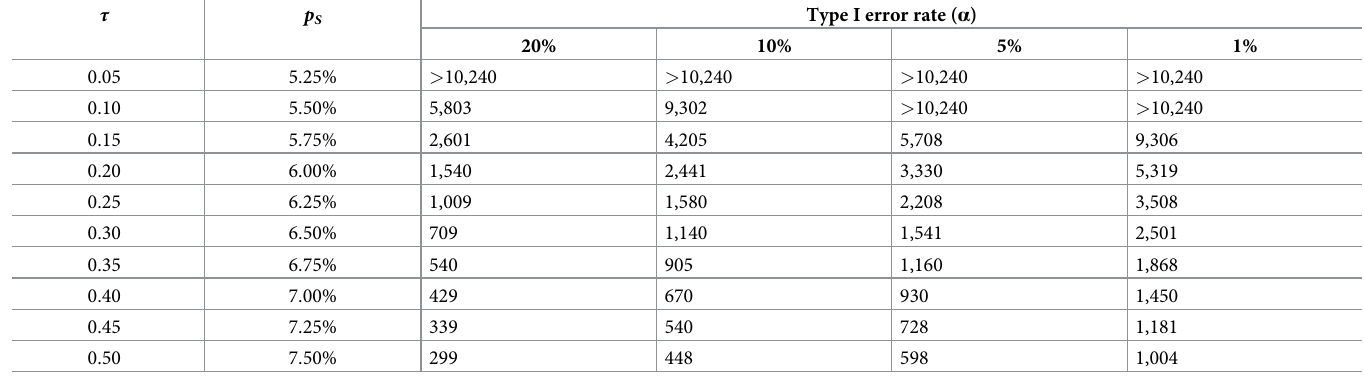
Table 6. Sample size required in order to obtain 80% power to detect that the probability of an adverse outcome is less than p S , for a range of Type I error rates ( α ), assuming that the true probability of an adverse outcome = 0.05 (i.e., 5%).